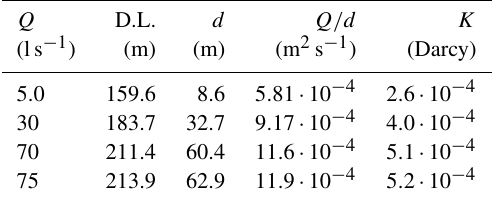
Table 1. Pumping test results in the case